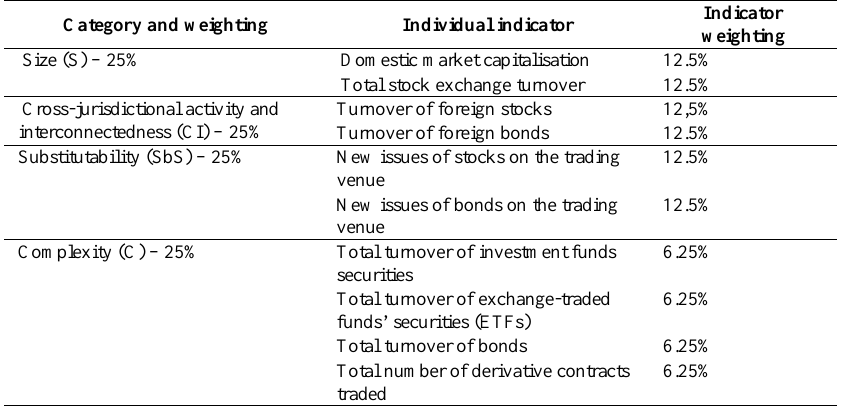
Table 1. Indicators for identifying systemically important regulated stock markets Category and